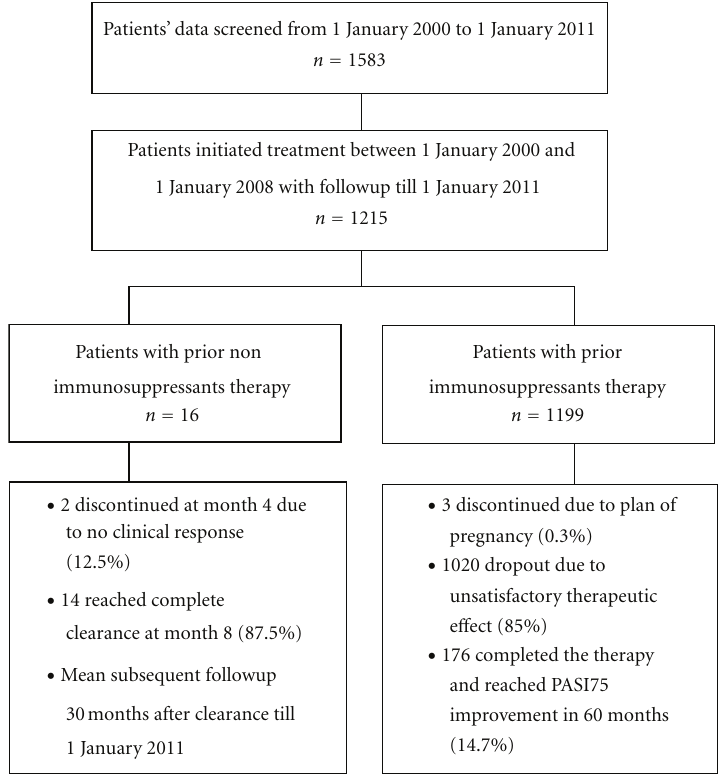
Figure 1: Flowchart and outcomes of the